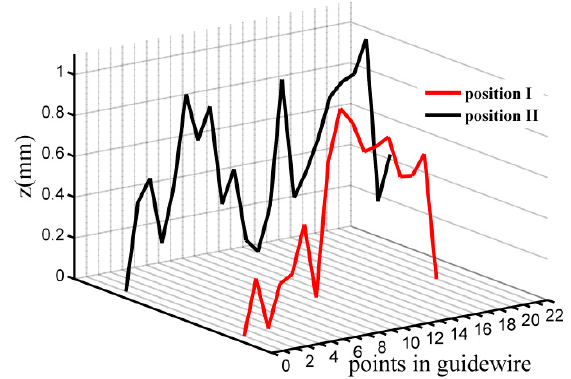
Figure 14. Position errors on SQP optimized guidewire shape.